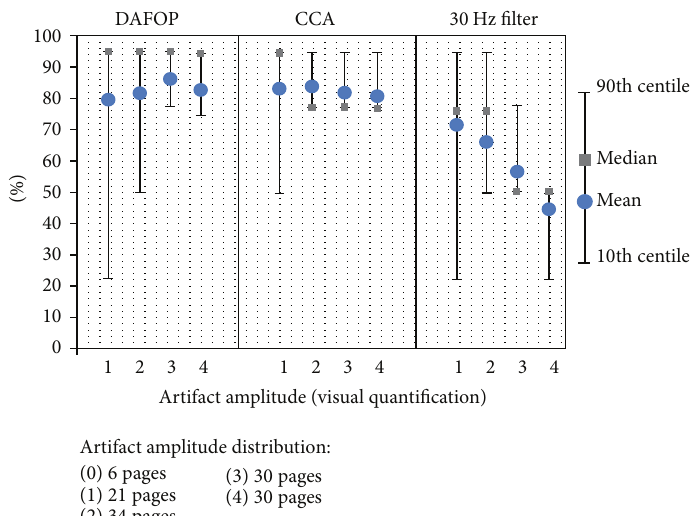
Figure 7: Distribution of the estimated amount of removed artifacts versus artifact amplitude for each method.